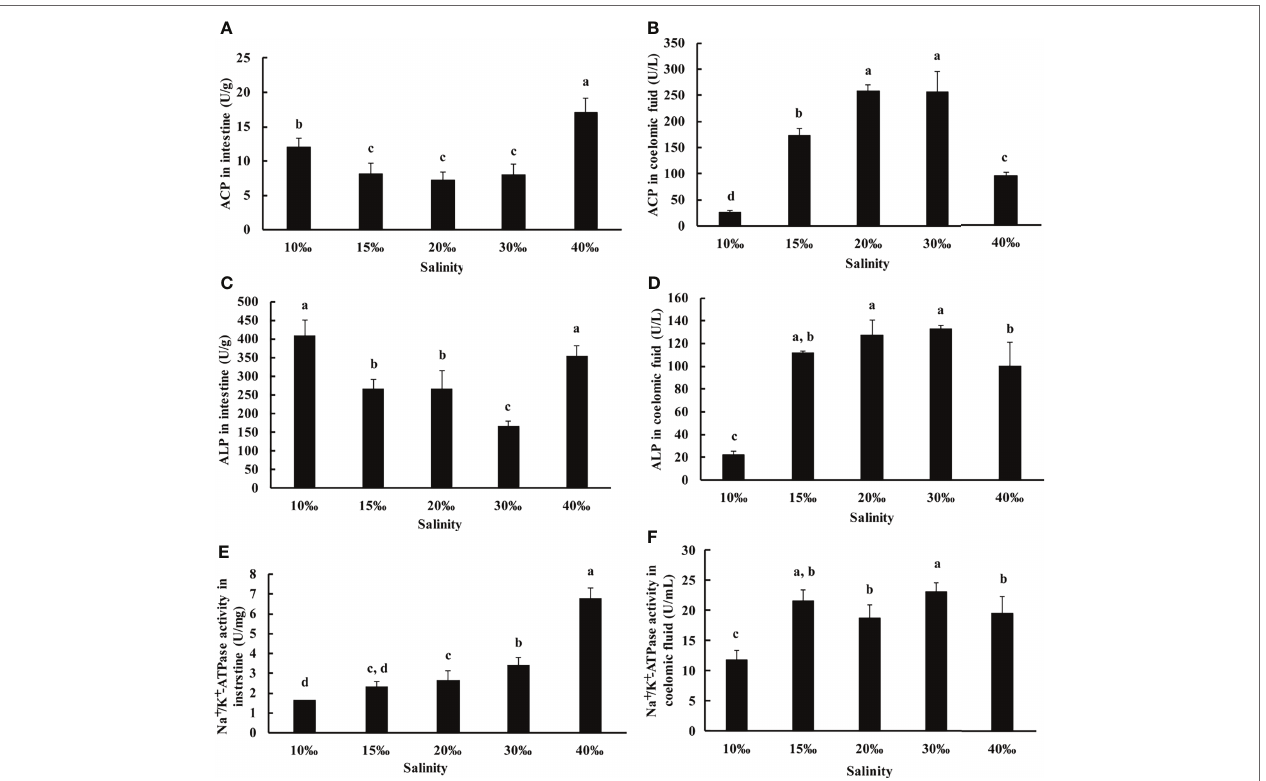
FIGURE 3 | The immune indices and Na + /K + -ATPase activity in the intestine and coelomic fluid ( A, B : ACP; C, D : ALP; E, F : Na + /K + -ATPase) of U. unicinctus juvenile reared in different salinities for 8 weeks. The data are mean values of three replicates + SD (n = 3). Different letters indicate significant differences at different salinity (ANOVA, Tukey’s test; P <